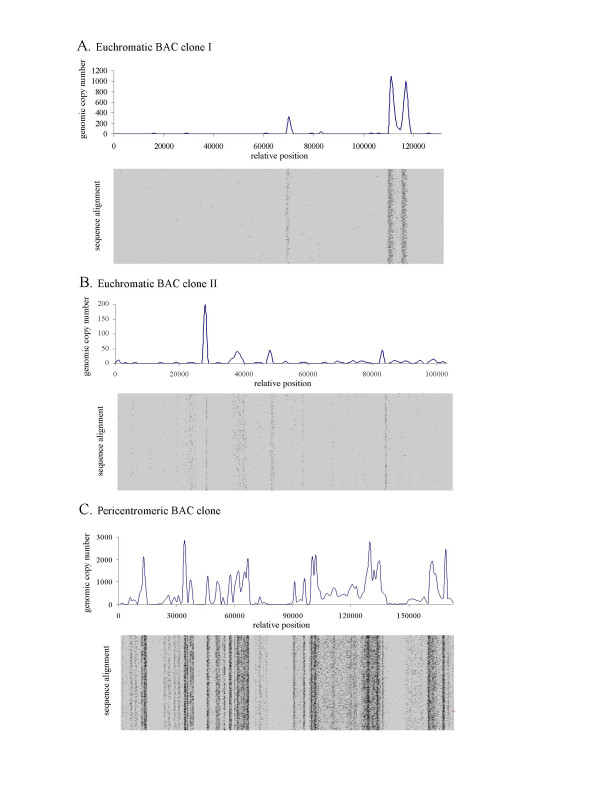
Alignment of sequence survey reads to BAC clones. The figure shows a graphic of the alignment of survey reads using BLASTZ to three genomic Bacterial Artificial Chromosome (BAC) sequences of soybean DNA, and estimation of copy number. Copy number was estimated according to the number of sequence survey reads aligning to each 1 kb window of the BACs. The alignment represents the superposition of identical or closely related sequences on the BAC sequence, in order to visualize the individual reads showing regions present in many copies per genome. The BAC sequences were: A) The euchromatic BAC described by Clough et al.(20); B) the euchromatic BAC GM_WBb0098N11; C) the BAC GM_WBb0078A23 from a heterochromatic region